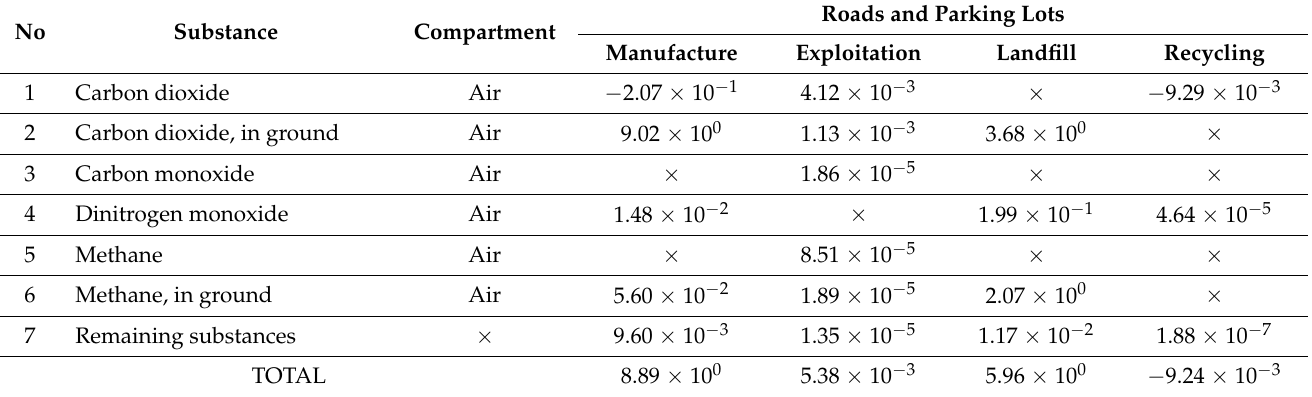
Table 11. Results of grouping and weighing the environmental consequences of emissions of com- pounds causing global warming due to roads and parking lots occurring at individual stages of the life cycle of the research